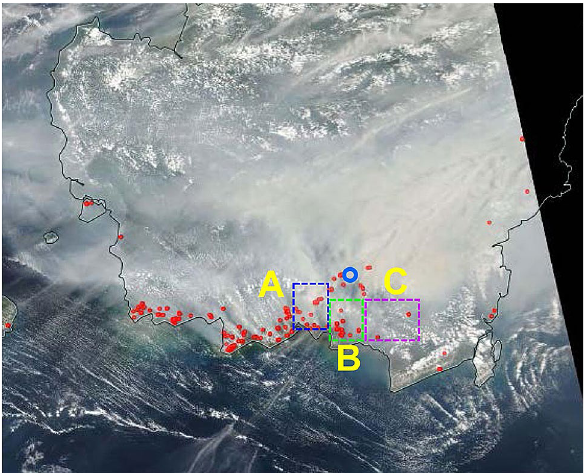
Figure 1. Terr and Aqua/MODIS/NASA true-color image of 15 October 2015 in Kalimantan, Indonesia. The imagery resolution is 250 m. The blue circle indicates the location of Palangka Raya. Red dots are MODIS fire hotspots. Study districts A, B and C are marked by the three squared areas. (Power Point